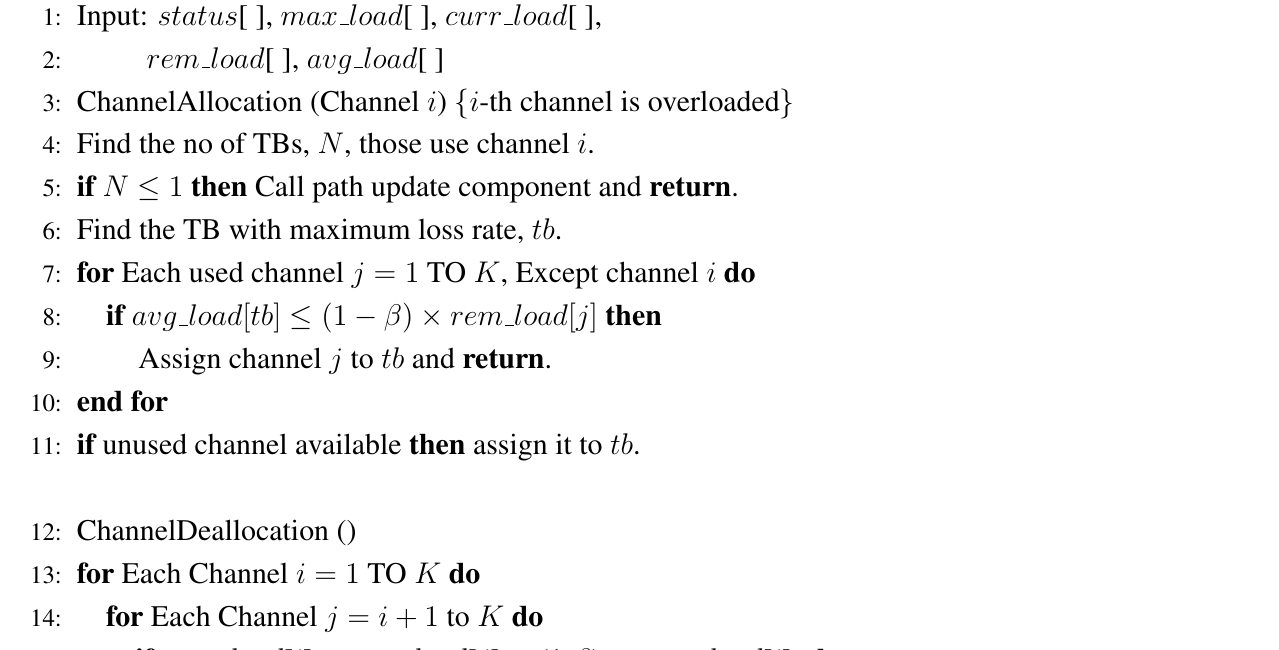
Algorithm 1 Channel Allocation and Deallocation